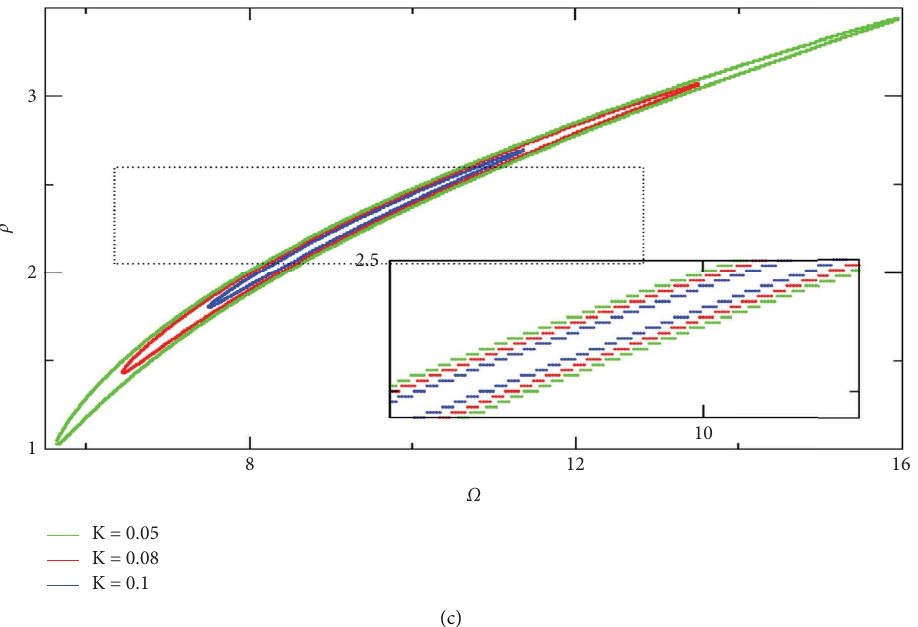
� 4 . 89 ; μ � 8 . 5 ; λ � 1 . 7625 ; M � 0 . 1 ; g � 10 ; C 0